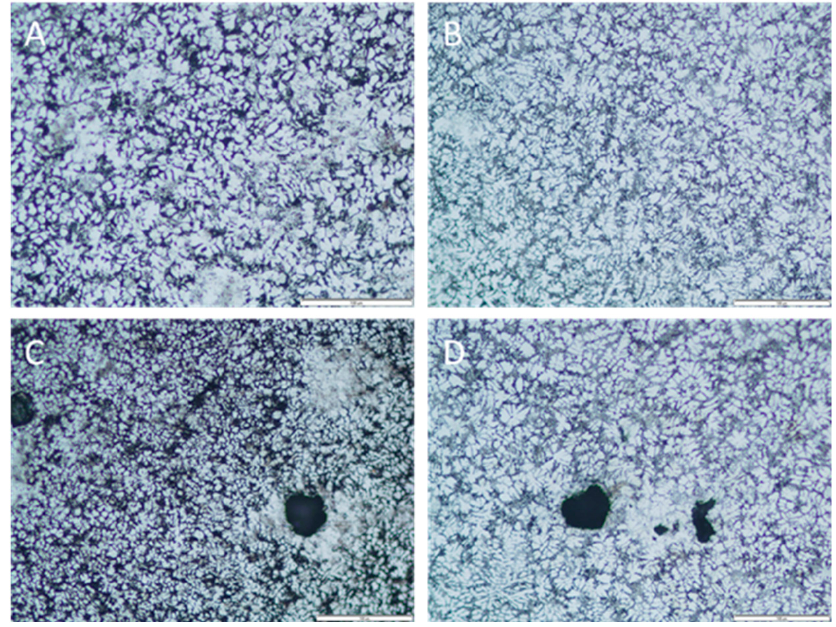
Figure 27. Sample surfaces after the chemical treatment, with a zoom of 200×: before ( A , C ), and after the intervention ( B , D ).